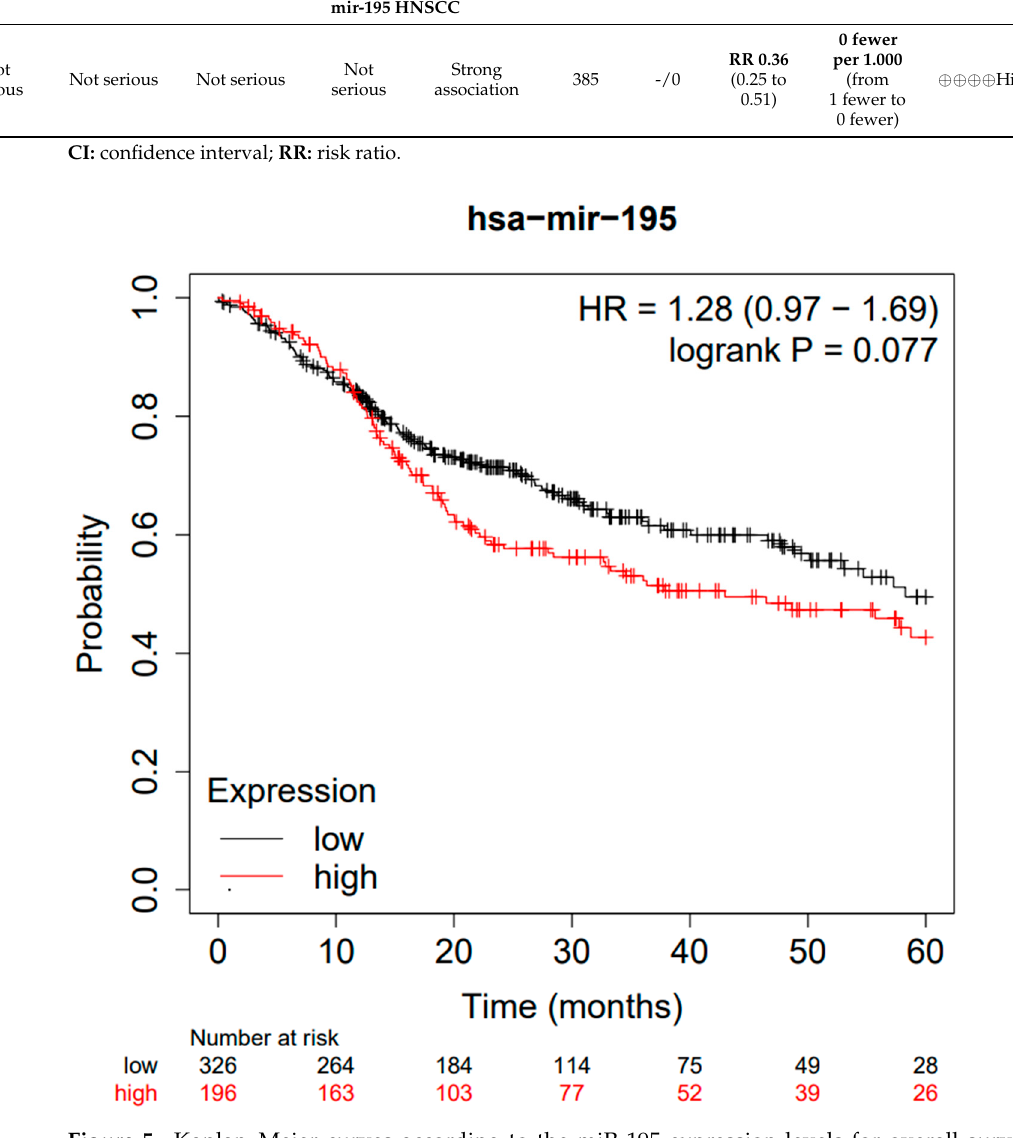
Figure 5. Kaplan–Meier curves according to the miR-195 expression levels for overall survival (OS) in patients with HNSCC (TGCA cohort). Kaplan–Meier curves were created by the public database and web application Kaplan–Meier Plotter (http://kmplot.com/analysis/, accessed on 20 December 2022).